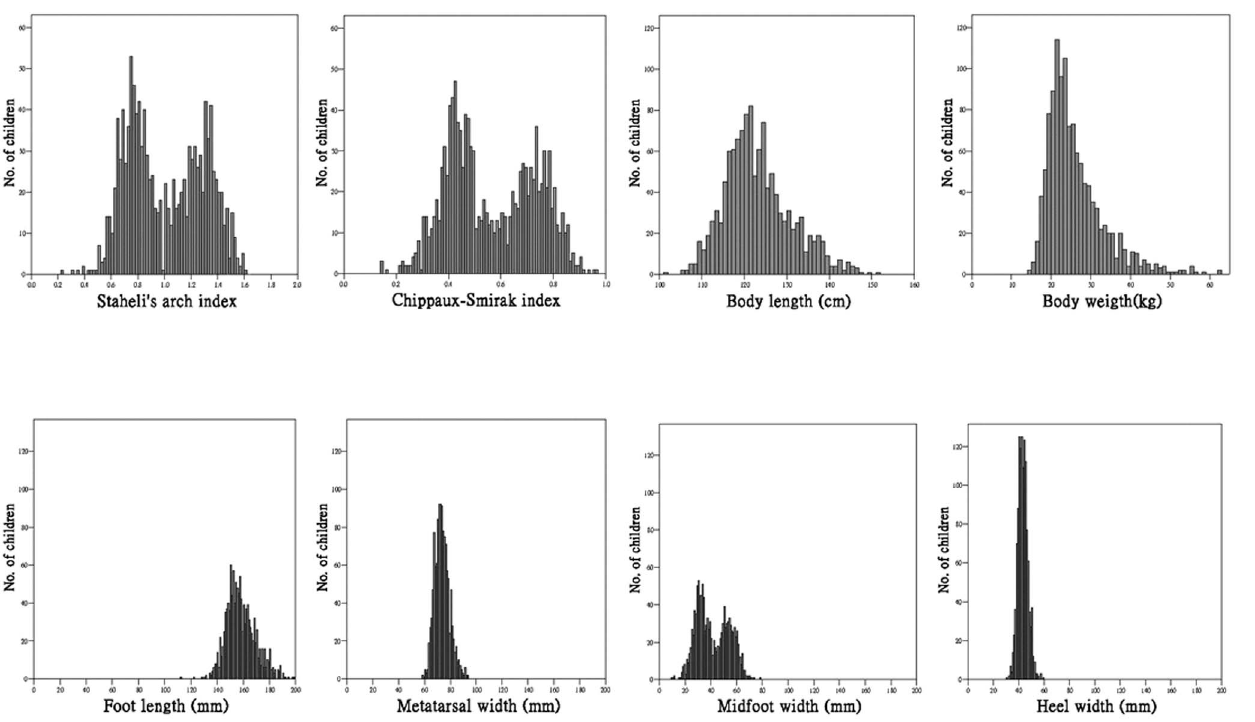
Fig. 2. Frequency distributions of body measures in 1228 children.